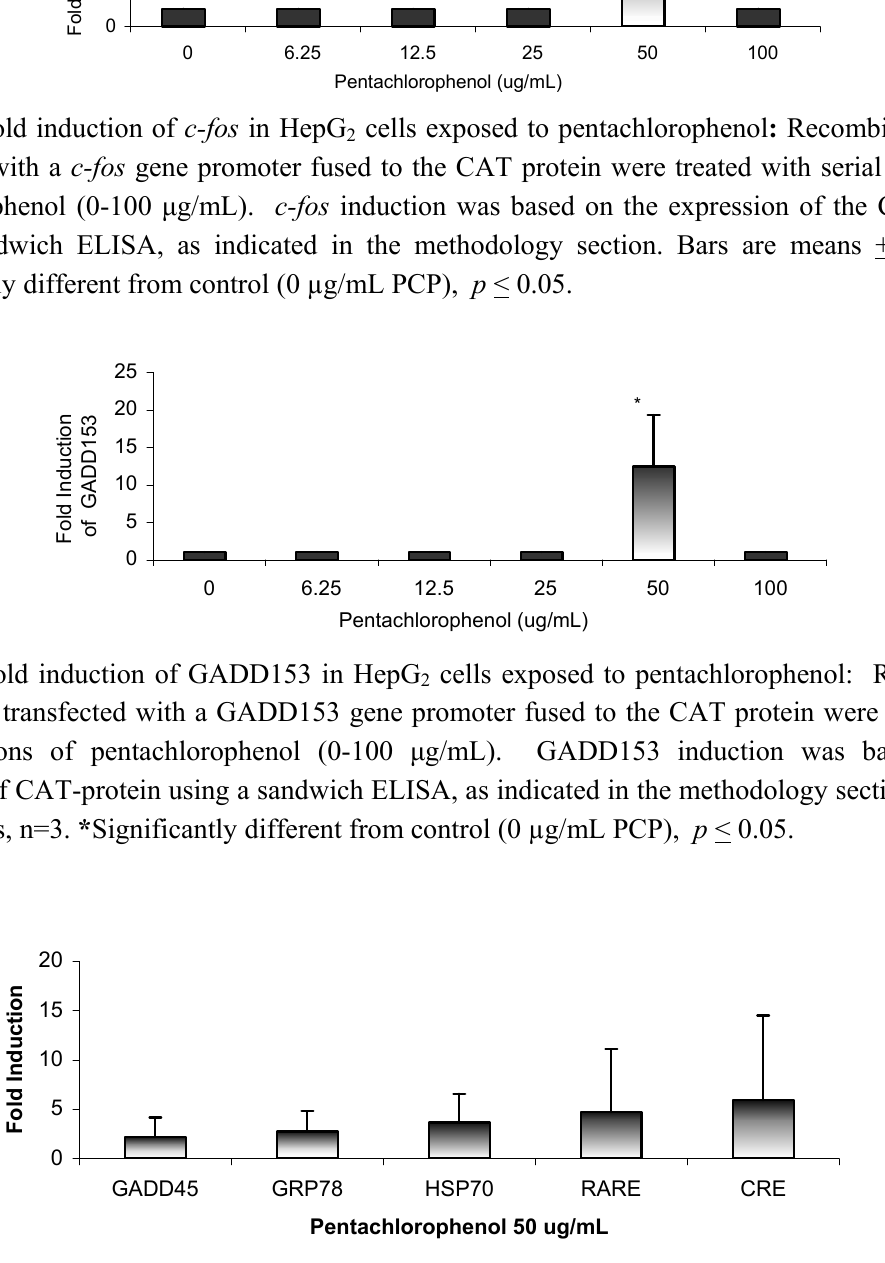
Figure 7. Marginal inductions of GADD45, GRP78, HSP70, CRE, and RARE in HepG of 50 µg/mL of pentachlorophenol : Recombinant HepG HSP70, CRE, and RARE gene promoters fused to the CAT protein were treated with serial dilutions of PCP (0-100 µ